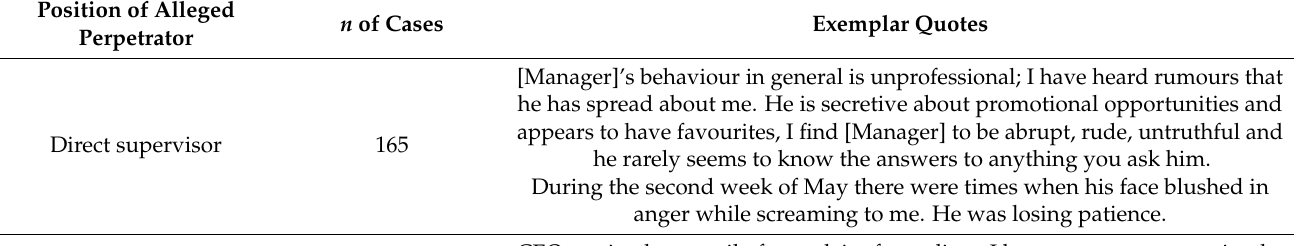
Table 2. Position of Alleged Perpetrator in Relation to the